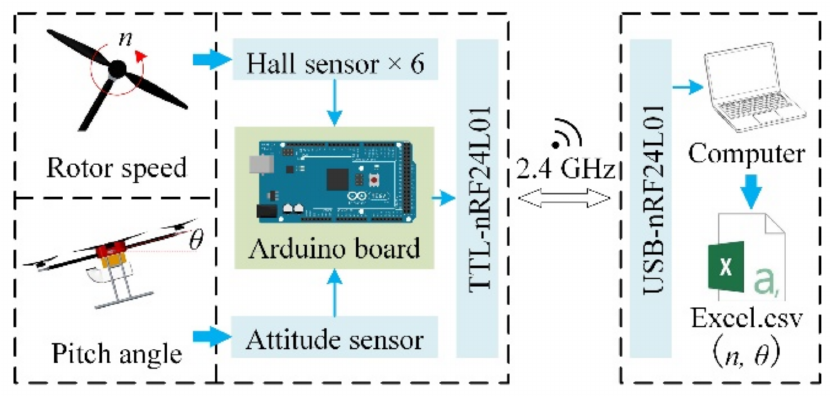
Figure 2. The framework of